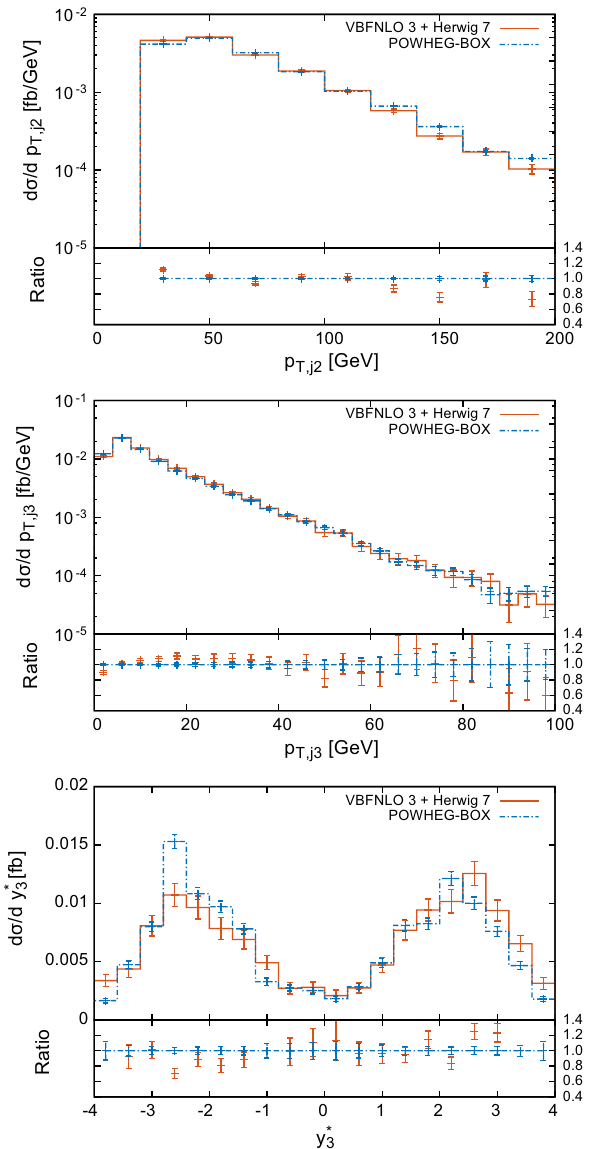
Fig. 10 Comparison of the multiplicative-matching implementations of Herwig 7 and POWHEG-BOX. Shown are distributions of the trans- verse momentum of the second ( top ) and third jet ( centre ) and the rel- ative rapidity of the third leading jet with respect to the tagging jets ( bottom ). Cuts and settings follow Ref.